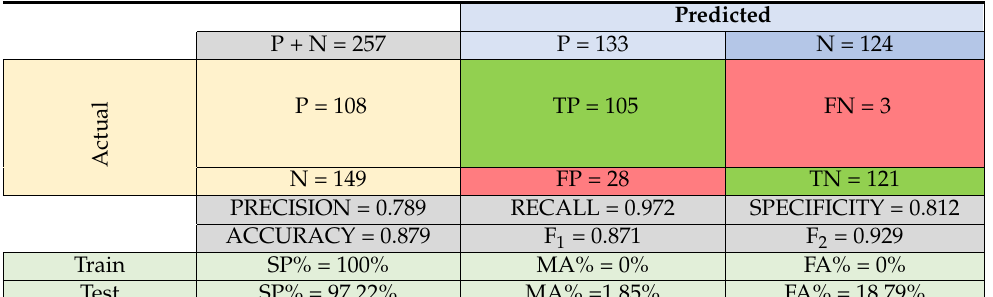
Table 6. Confusion matrix and performance indices of the GTM prediction model evaluated on the test set.